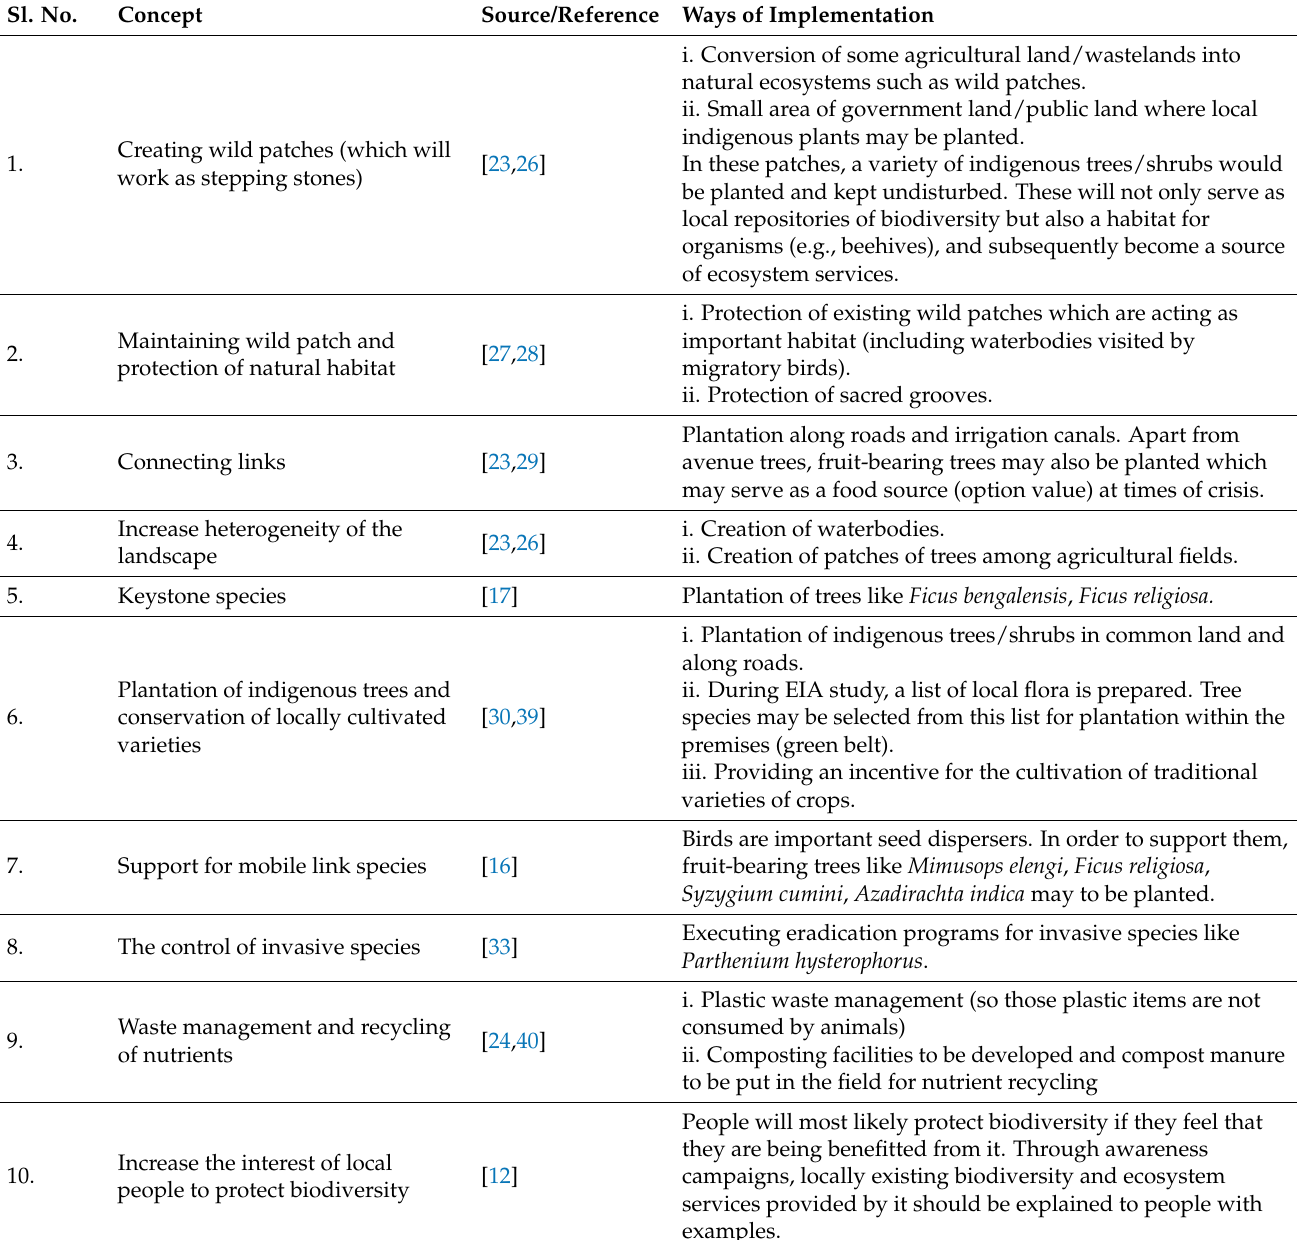
Table 4. A suggestive list of components from which people may choose to request project proponents to spend under CER for biodiversity